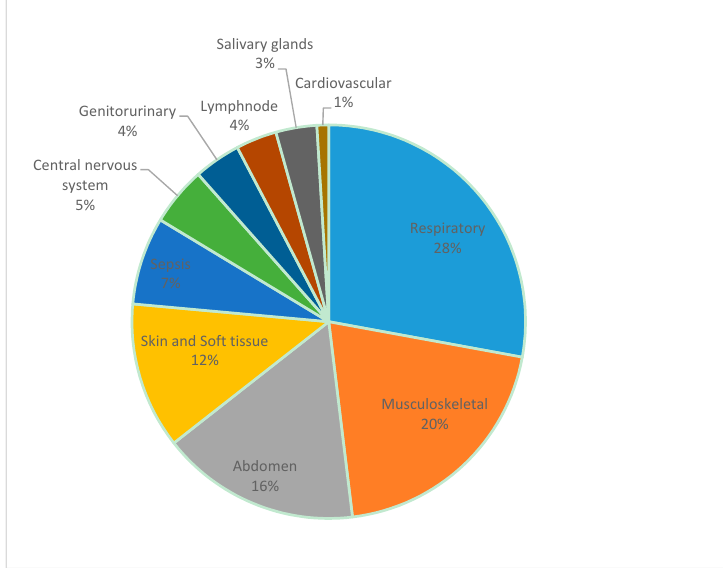
Figure 4. Systems affected by melioidosis in Sri Lankan patients.